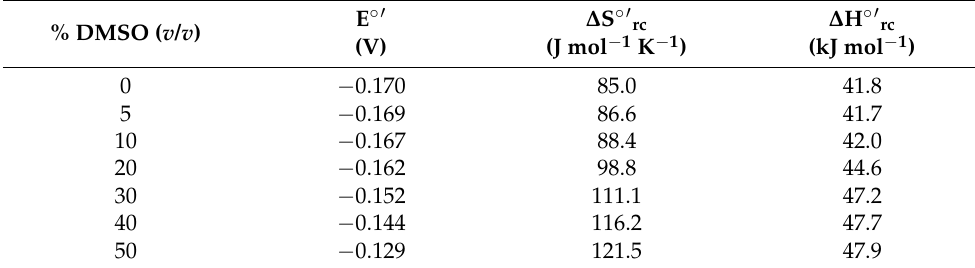
Table 1. Reduction thermodynamics for the M80A cytc variant in mixed water/DMSO solutions at increasing DMSO content [ a